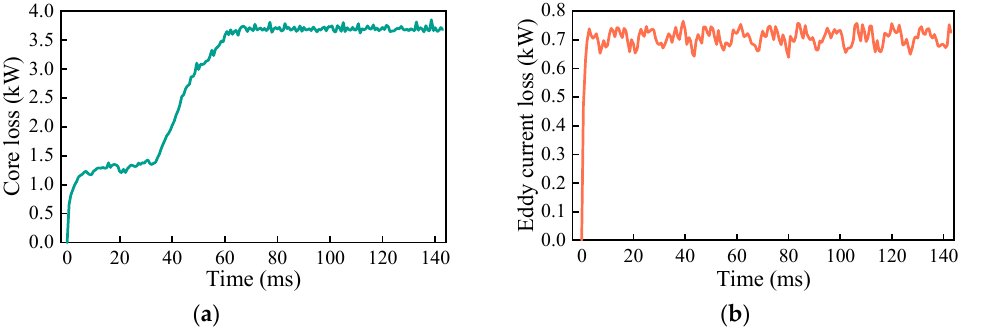
Figure 6. ( a ) Core loss and ( b ) eddy current loss of the PM under rated load.